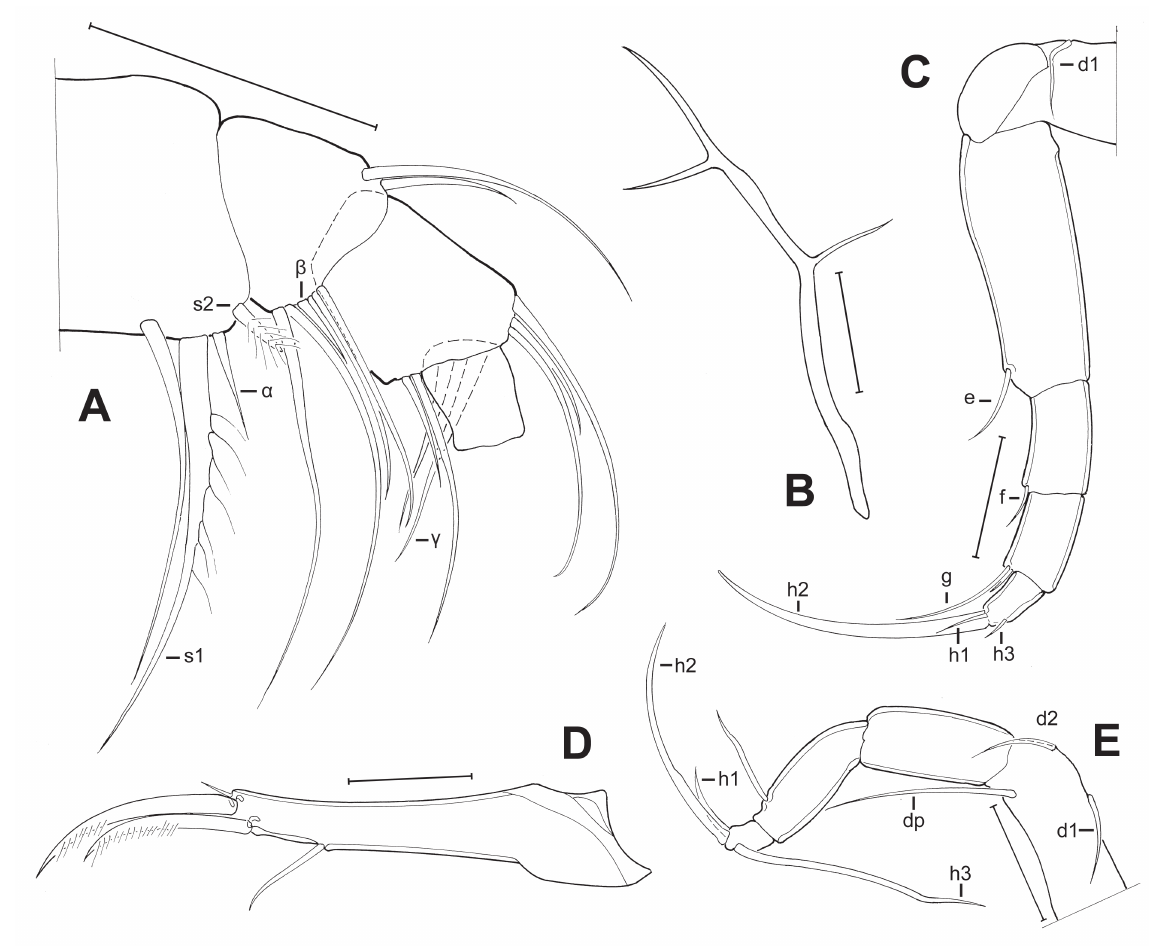
Fig. 9. Limbs of Pseudocandona claudinae sp. nov. (♀). A . Md palp (MZUSP 32682). B . Attachment of the caudal ramus (MZUSP 32682). C . T2 (MZUSP 32682). D . Caudal ramus (MZUSP 32682). E . T3 (MZUSP 32682). Scale bars: A–E = 50 µ